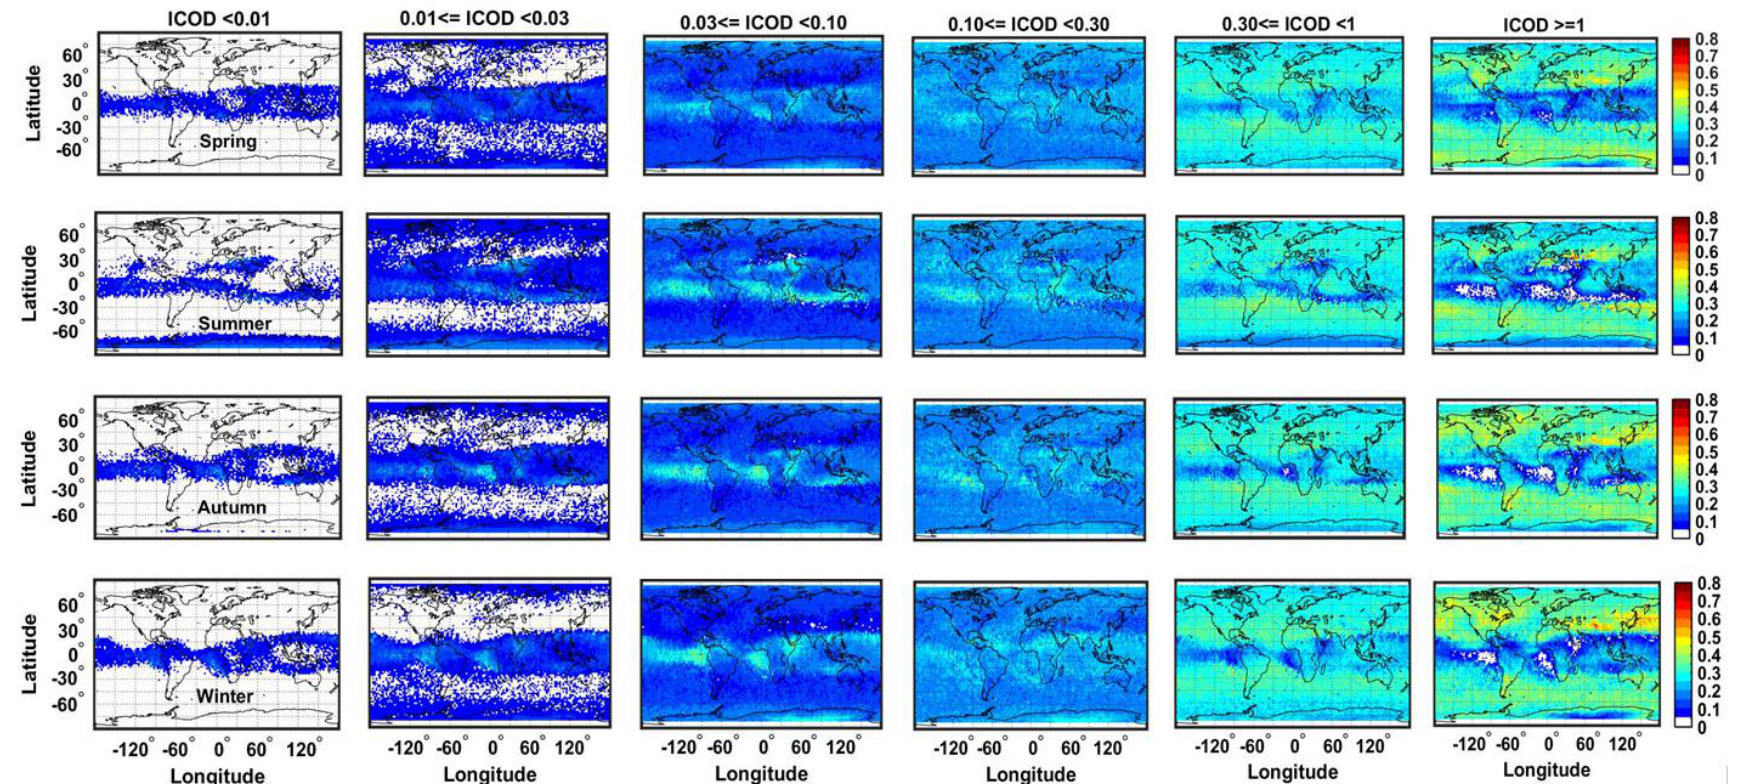
Figure 5. Spatial and seasonal occurrence frequency of ice cloud optical depth (ICOD) with six ranges based on the CALIOP 10-year measurements (day plus night). The white color represents a value of less than 0.05.